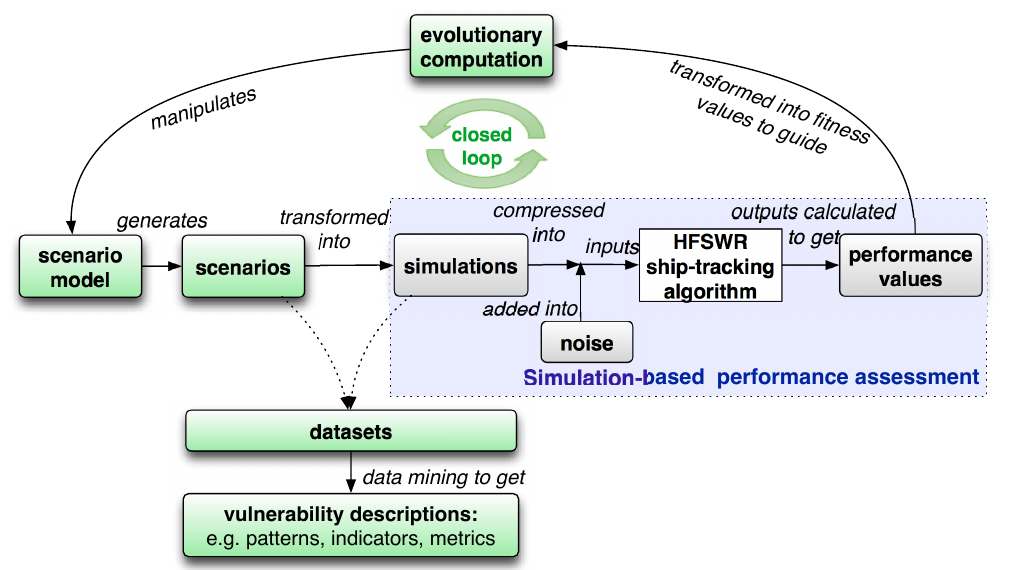
Figure 1. System block diagram: The blue block illustrates the existing simulation-based performance assessment method for the HFSWR ship-tracking algorithm, while the green blocks highlight the contributions of our approach, with the label on each of the directed lines denotes the relationship between or the operation involved in the two connected entities or concepts in the